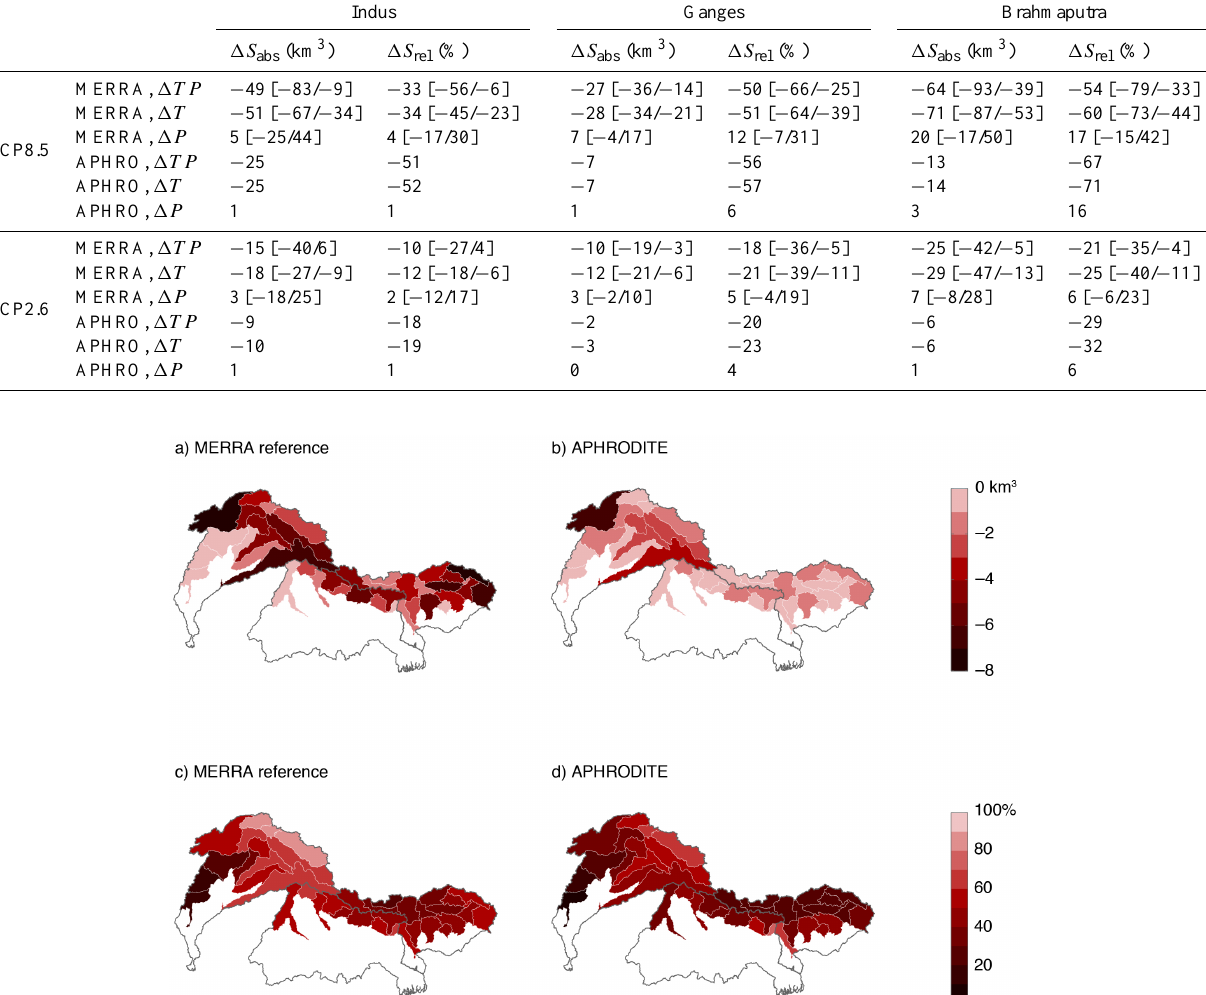
Table 5. Projected change in annual snowfall from 1971–2000 to 2071–2100, with reference to terrain-adjusted MERRA and APHRODITE. (cid:49)S abs (km 3 ) is the absolute change, and (cid:49)S rel (%) is the relative change compared to the present-day MERRA reference snowfall. Values are presented with the CMIP5 multi-model mean as the main value and the span of individual models in brackets (MERRA only). (cid:49)T P indicates that changes in both temperature and precipitation are included, whereas (cid:49)P and (cid:49)T denotes changes only in precipitation or temperature, respectively. Indus Ganges